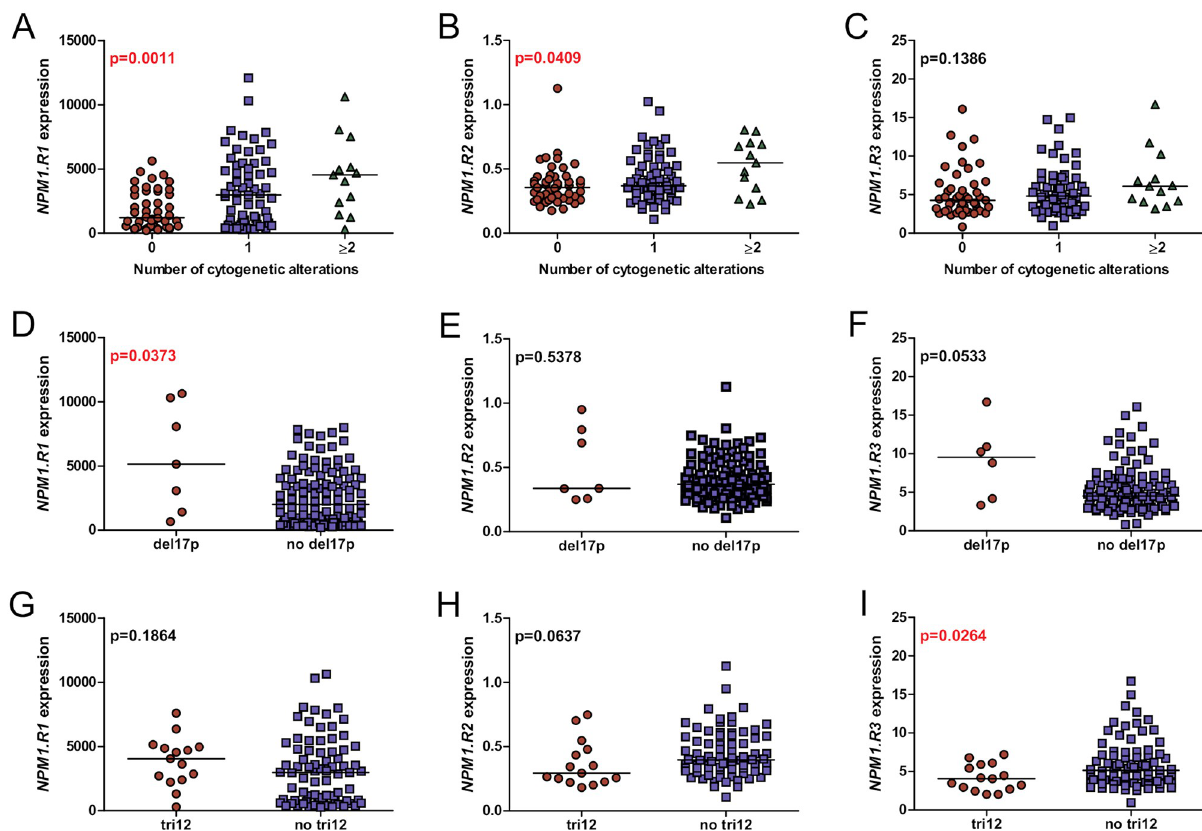
Fig 3. The expression of NPM1 splice variants regarding the cytogenetic aberrations. The comparison of NPM1 transcript levels in CLL samples, according to: (A-C) the number of presented cytogenetic alterations, (D-F) the presence of del17, and (G-I) tri12. Mann-Whitney P values are included. Each dot represents one sample. Statistically significant p values are indicated in